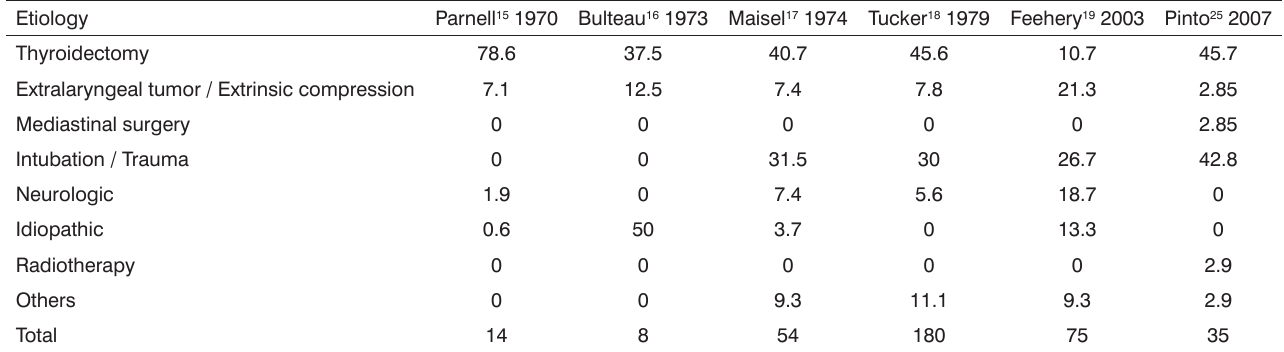
Table 3. Etiology of bilateral vocal fold immobility (percentage %).